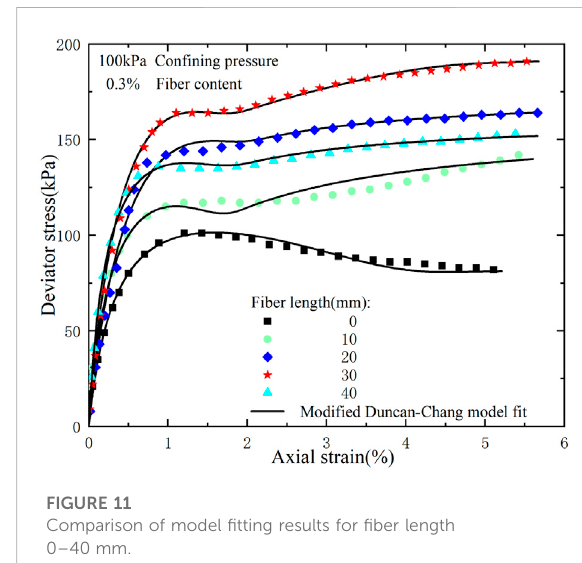
FIGURE 11 Comparison of model fi tting results for fi ber length 0 – 40